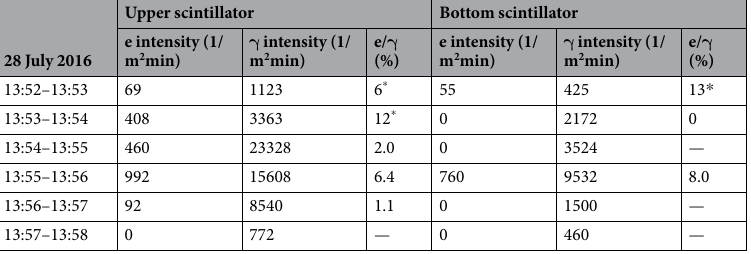
Table 1. Recovered intensities of the electrons and gamma rays of TGE for the upper and lower 20 cm thick scintillators. * For the low intensities the estimate of electron fraction is unstable.